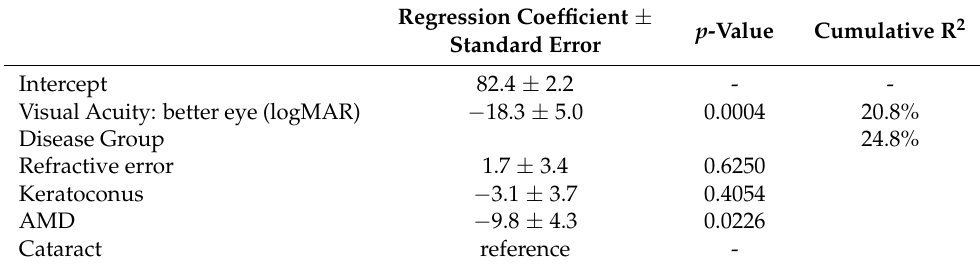
Table 4. Multivariate analysis of the total score of NEI VFQ-25 ( n = 126). Regression Coefficient ± p -Value Cumulative R 2 Standard Error Intercept 82.4 ±